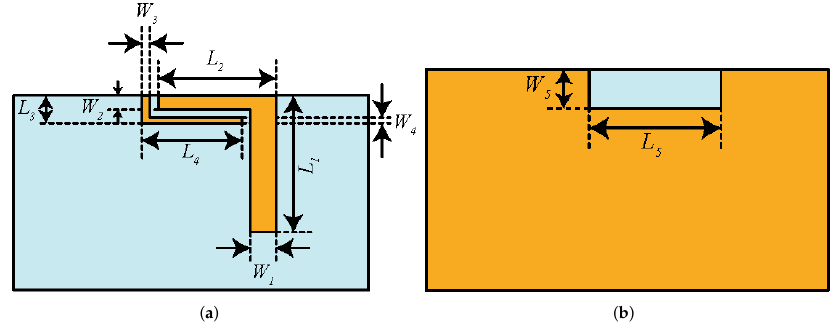
Figure 1. The proposed single antenna element (a) front-side (b) back-side.